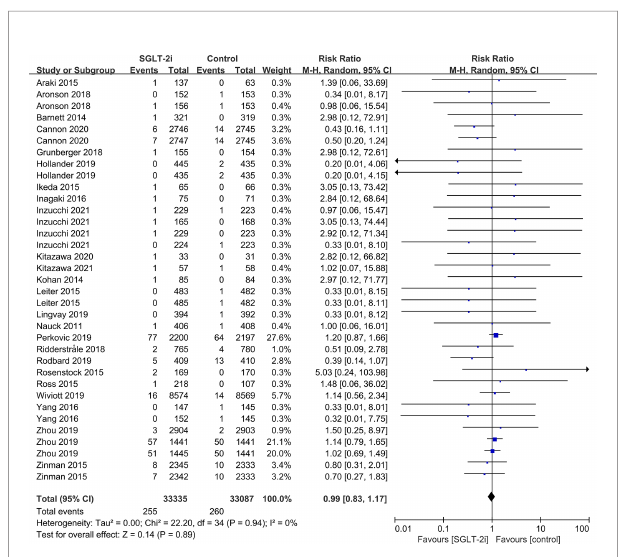
FIGURE 4 | Effect of SGLT-2i on incidences of retinal disease compared with control in T2DM